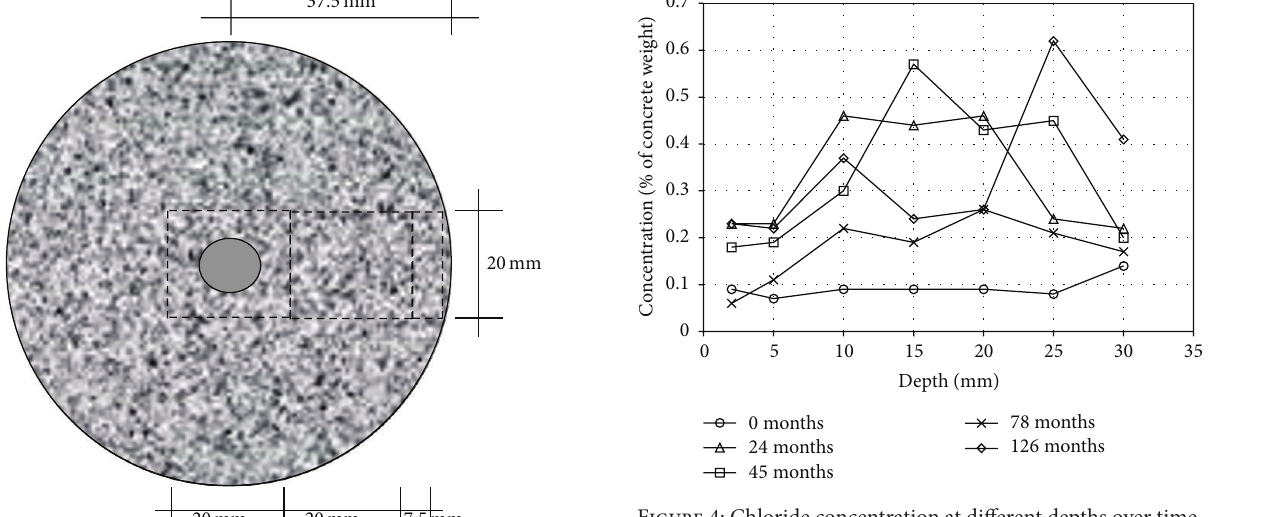
Figure 4: Chloride concentration at different depths over time.